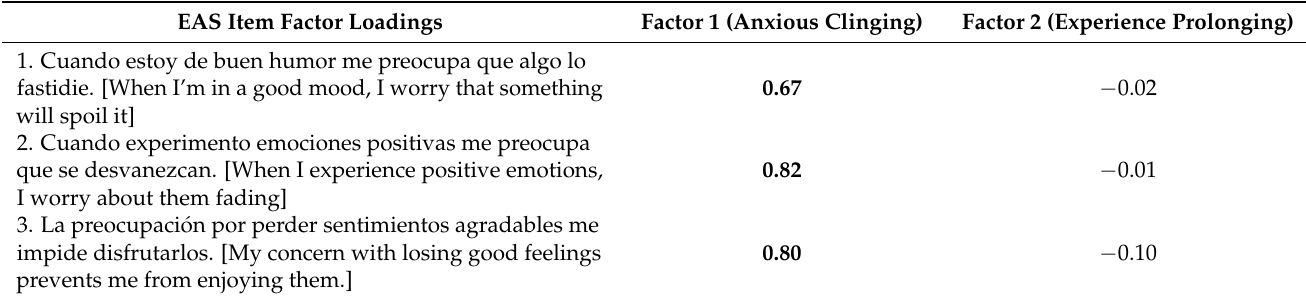
Table 1. Factor loadings from Robust Unweighted Least Squares Factor Analysis, and alpha and omega coefficients. EAS Item Factor